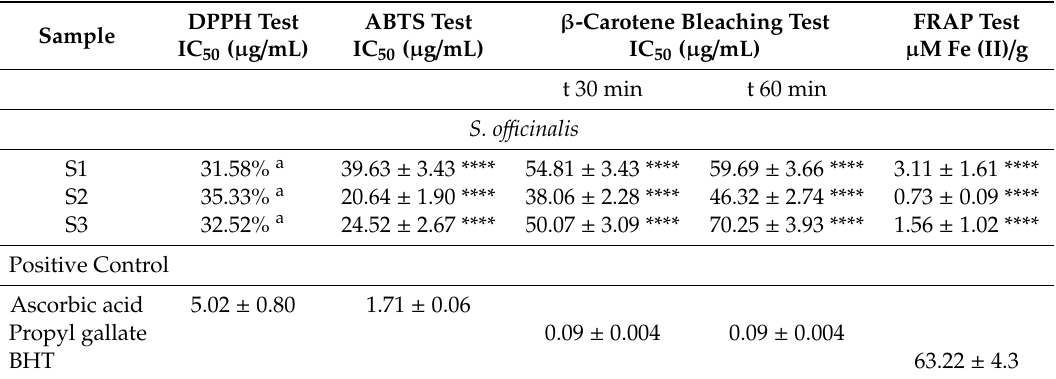
Table 3. In vitro antioxidant activity of sage essential